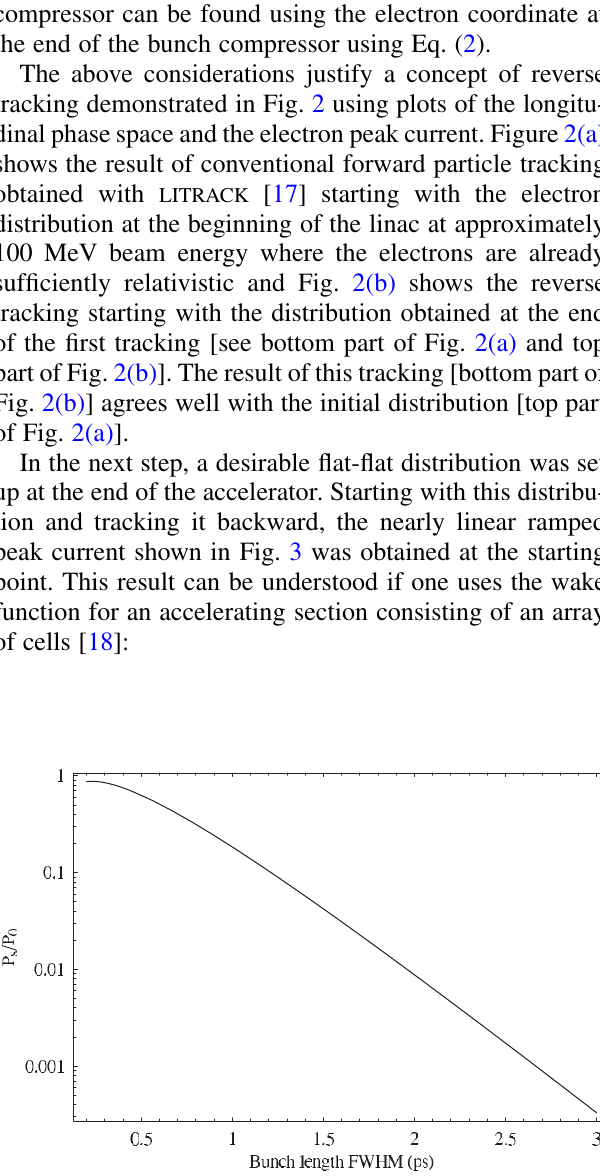
FIG. 1. Suppression of CSR due to the shielding effect from the vacuum chamber with a gap of 8 mm. This result was obtained by following the recipe proposed in